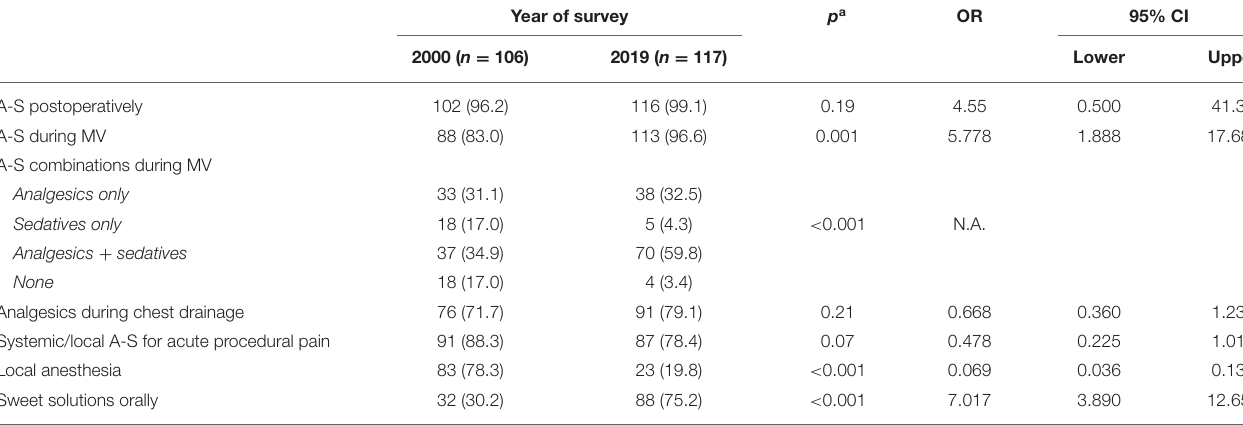
TABLE 2 | Physicians’ practices for management of postoperative and procedural